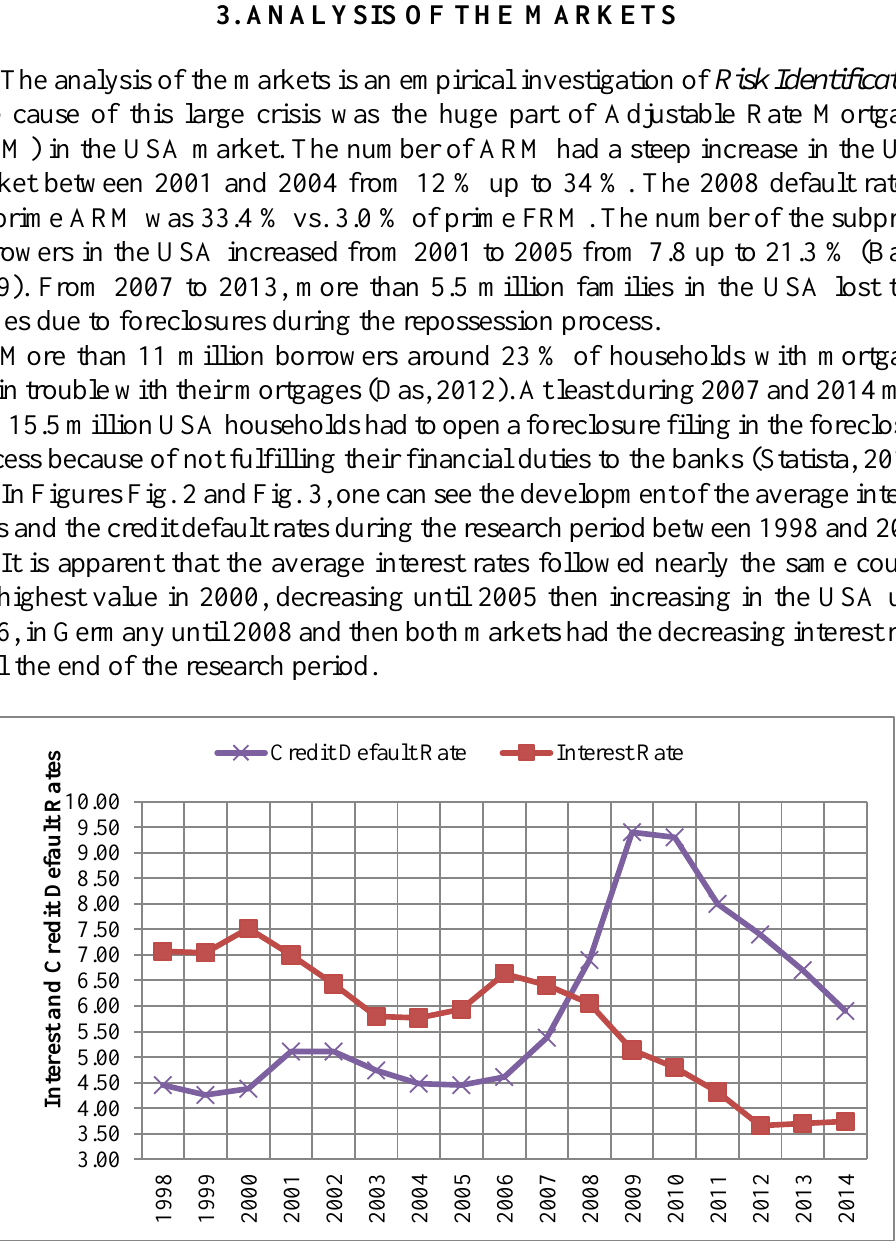
Fig. 2. The interest and credit default rates in the USA, 1998–2014 (developed by the author, based on data by Statista